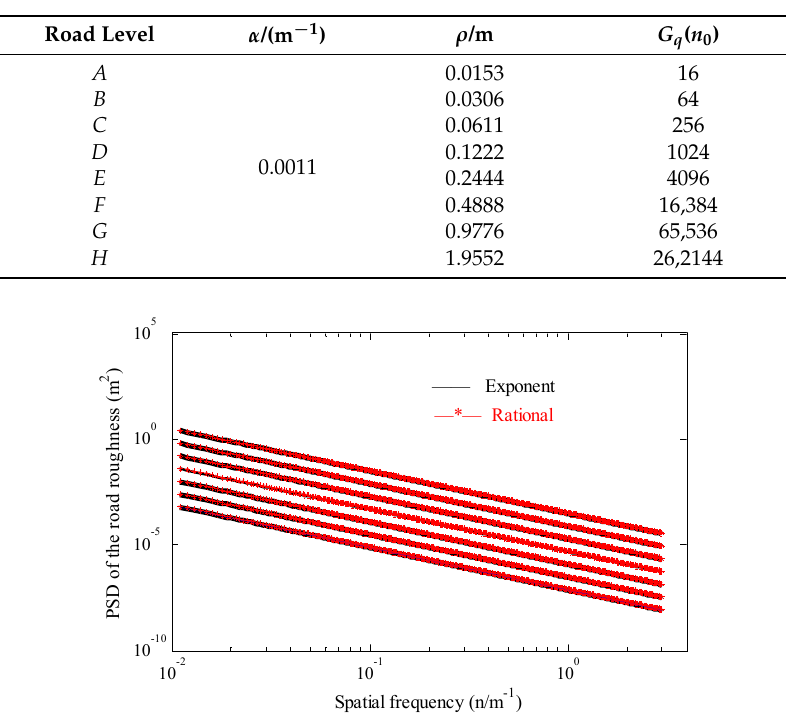
Table 1. Estimated results of road parameters.